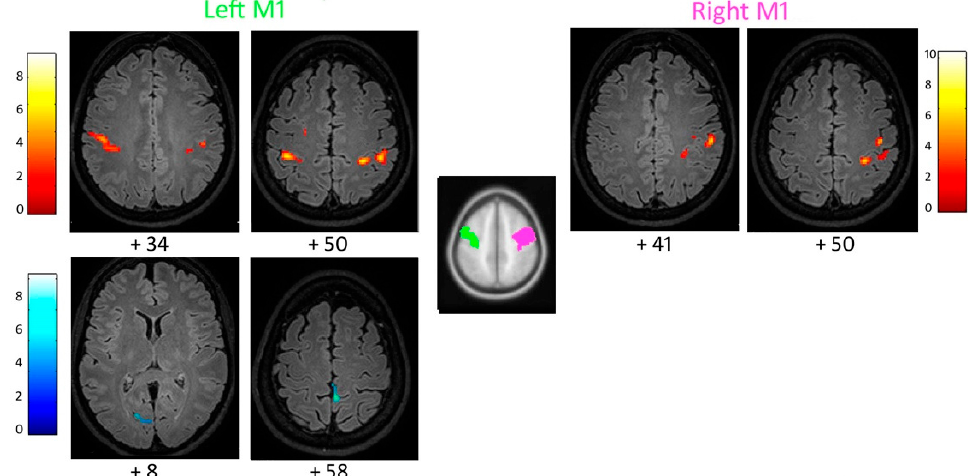
Figure 1. Increased ( top ) and reduced ( bottom ) functional connectivity of the patient’s left and right primary motor cortex M1, with respect to the control group (cluster size threshold k > 87 and k > 84, corrected at α < 0.05, respectively). Clusters are shown in the axial slices of the patient’s normalized flair 3D image.